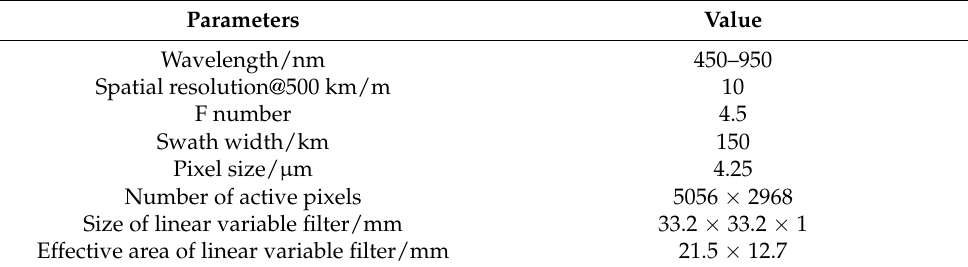
Table 1. The parameters of the hyperspectral Figure 2. The principle of the digital domain time-delayed integration (TDI).